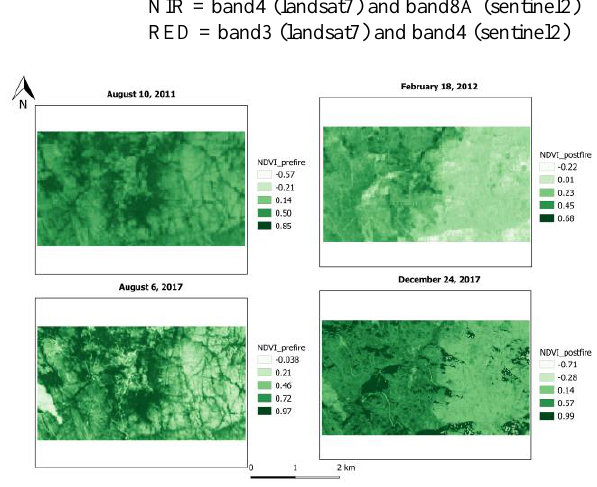
Figura 4. NDVI prefire and postfire in study area